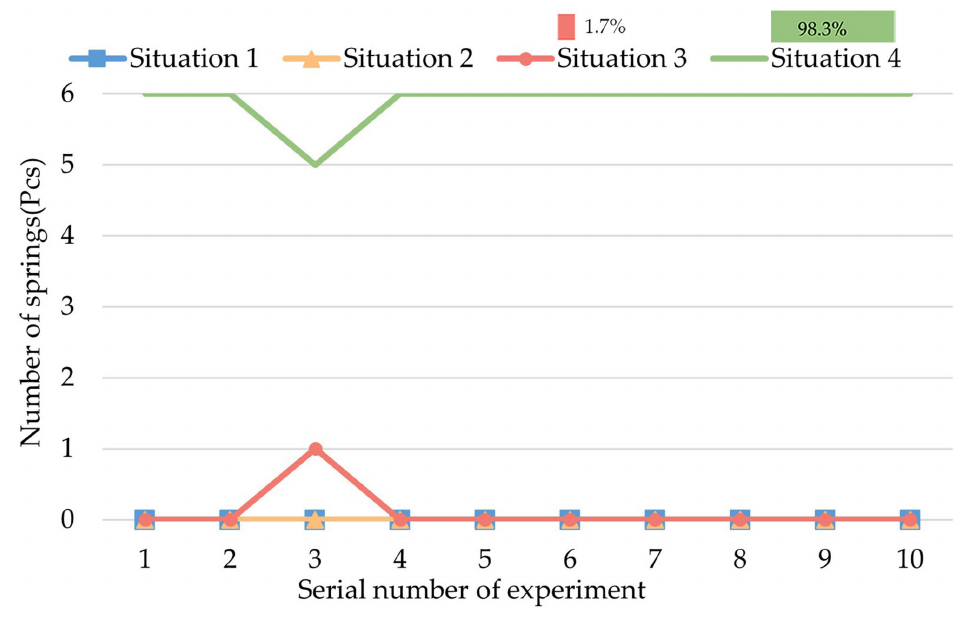
Figure 13. Result of Group IV of experiments.